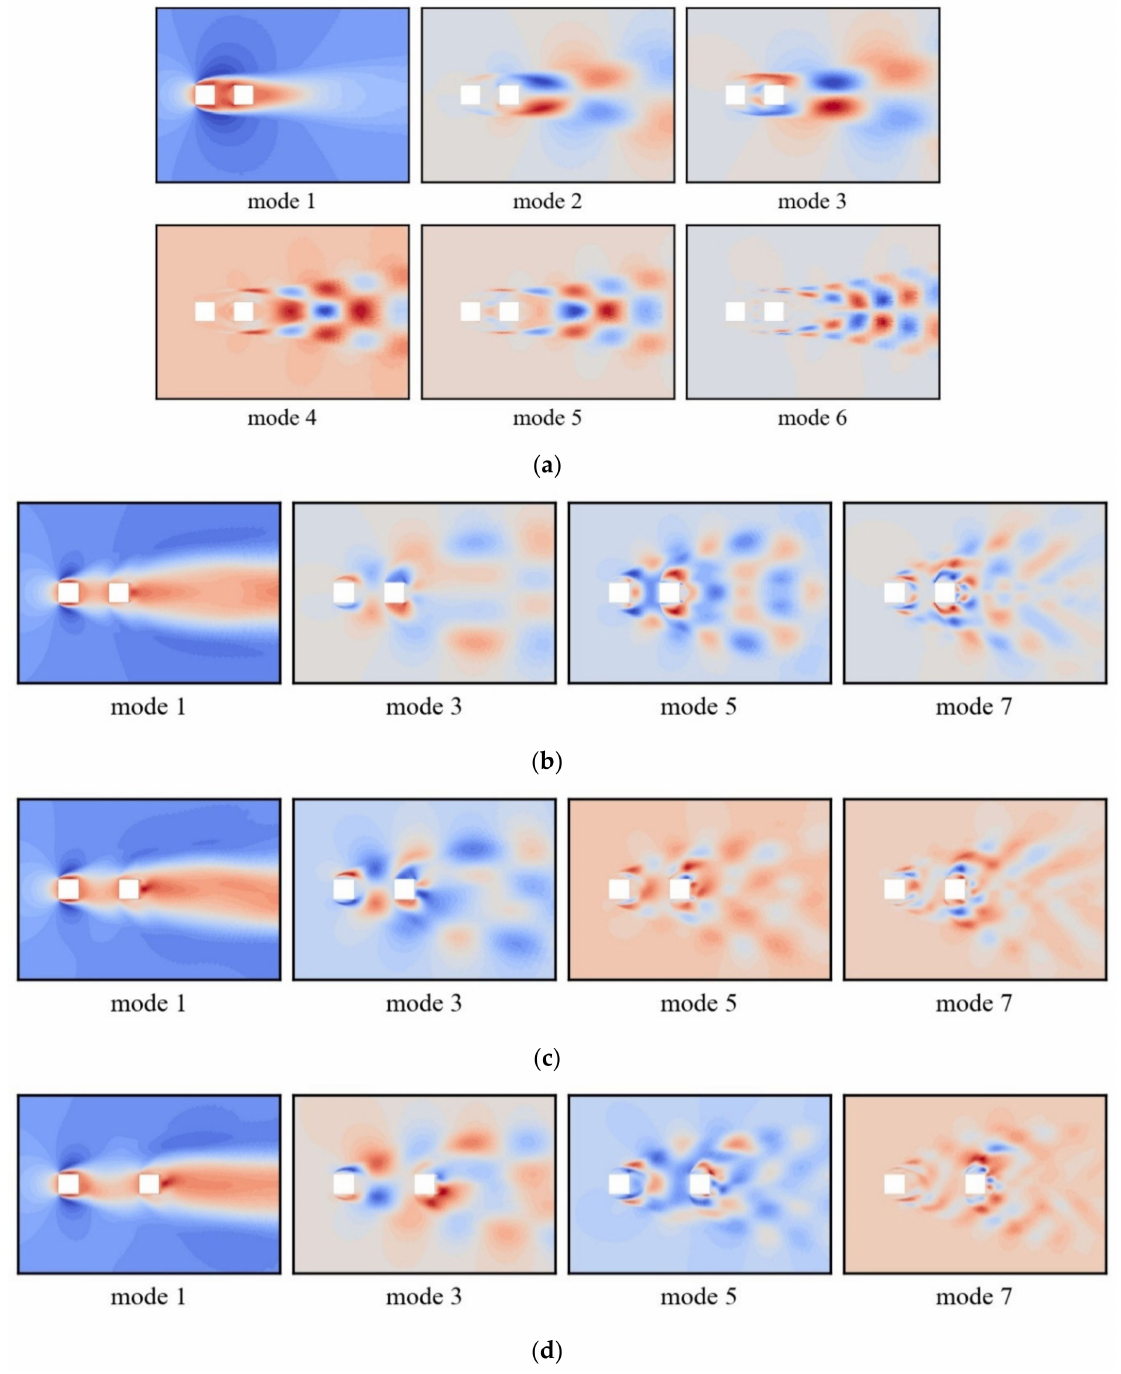
Figure 6. Dominant POD modes at di ff erent spacing ratios: ( a ) L / D = 2; ( b ) L / D = 2.5; ( c ) L / D = 3; ( d ) L / D =